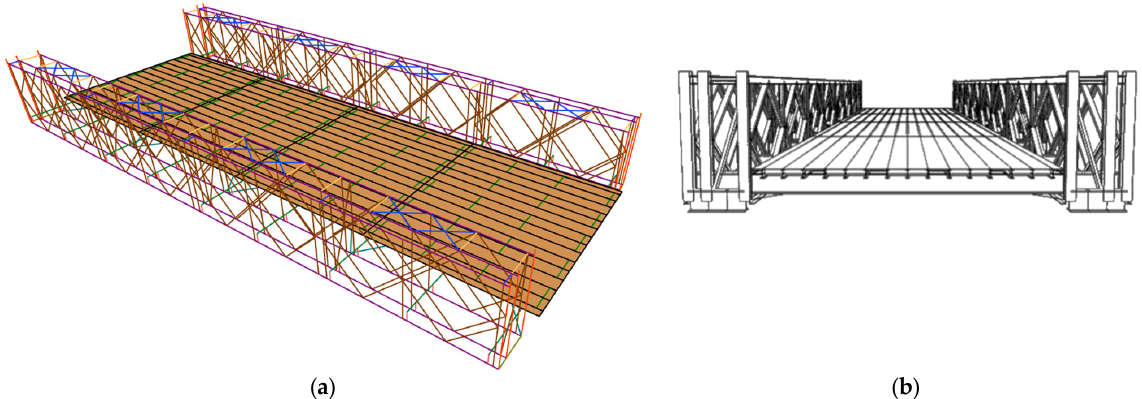
Figure 8. Geometry of complete spatial FEM model in the case of the shortest analysed span TS-12 (40 ft): ( a ) model from beam and shell elements; and ( b ) front view visualization.